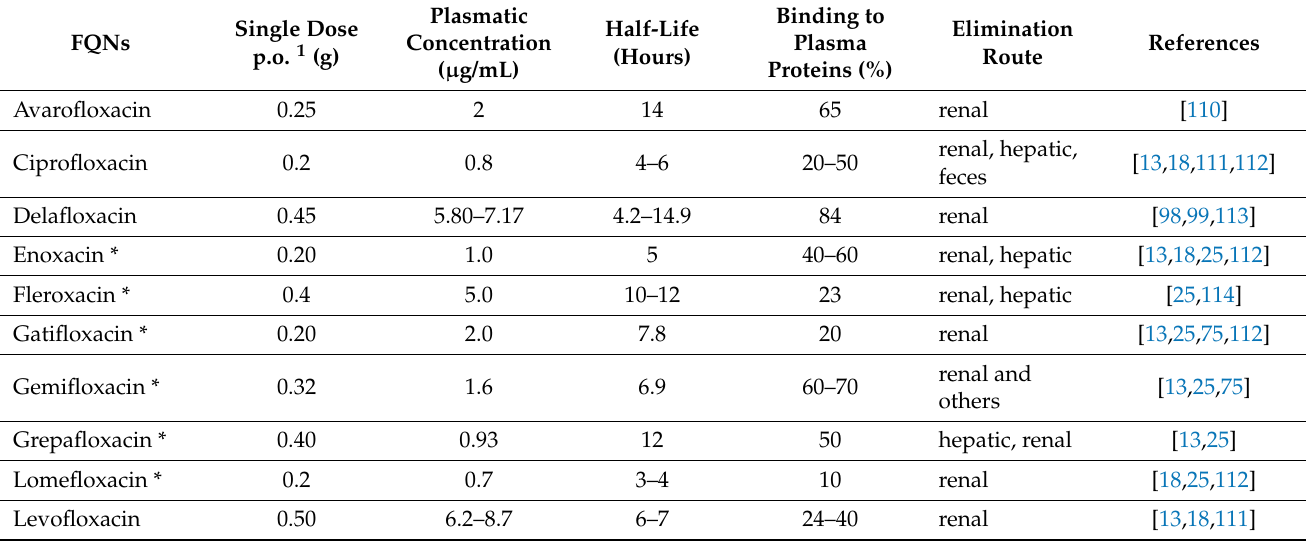
Table 3. Pharmacokinetic data of some representative